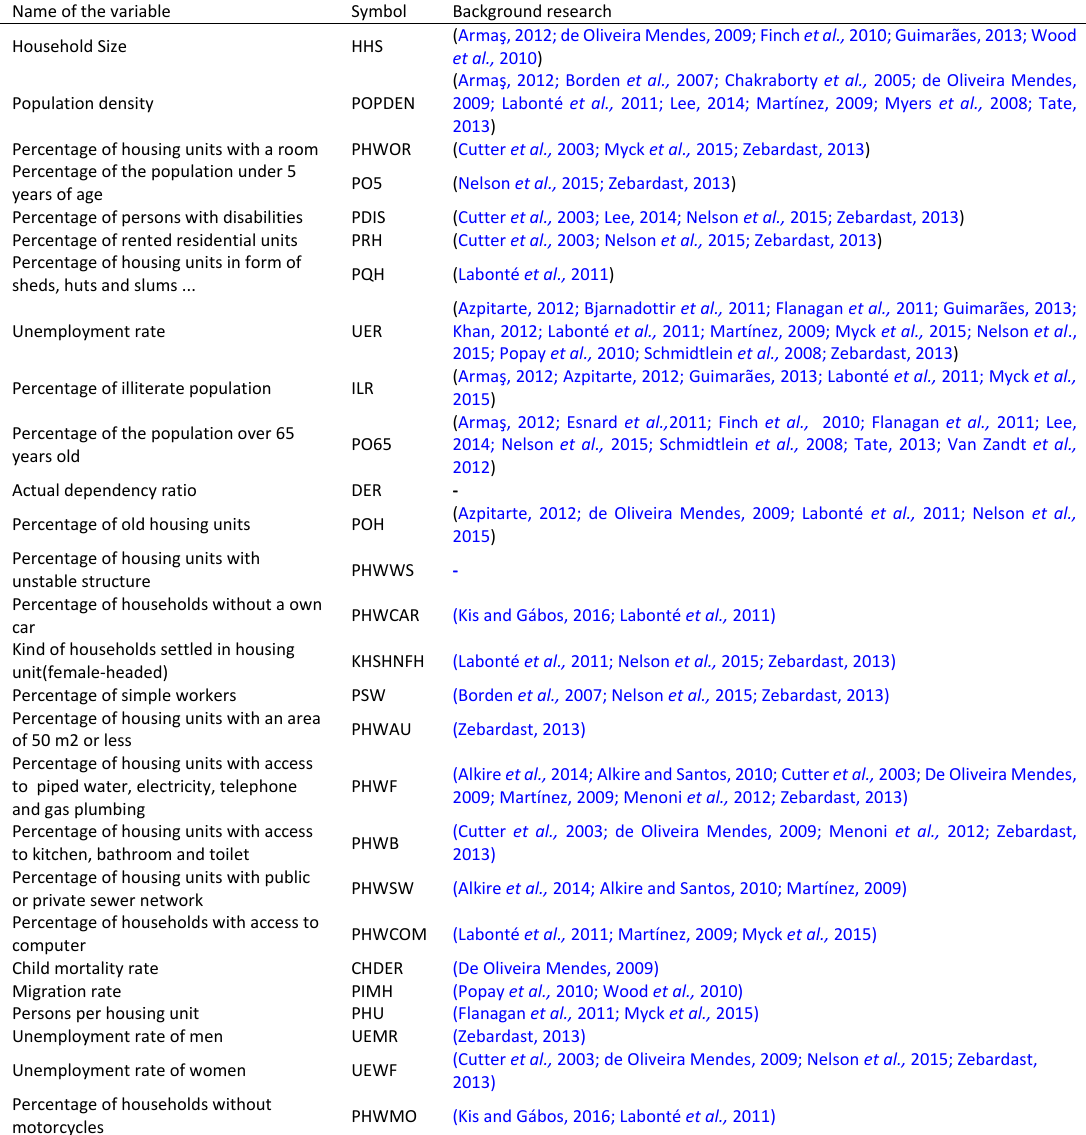
Table 1. Urban poverty substantive indicators Table 1: Urban poverty substantive